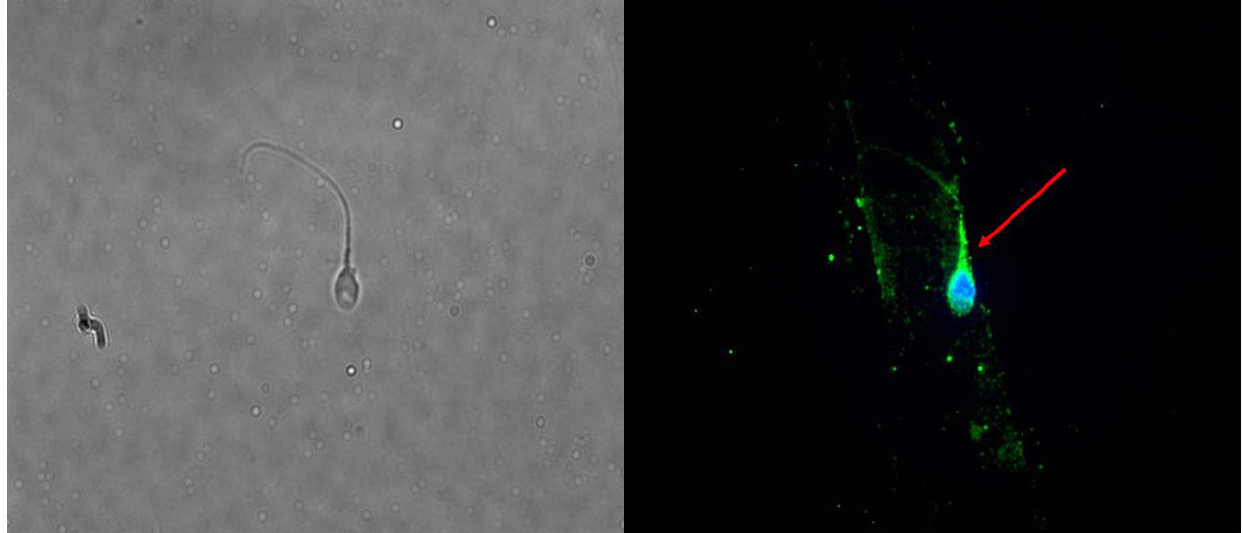
Figure 1. Immunolocalization of the follicle-stimulating hormone receptor (FSHR) protein in human spermatozoa. Immunofluorescence (IF) analysis of spermatozoa. The protein is present in the post- acrosomal segment, neck, midpiece, and tail of the spermatozoon. Magnification 100×. IF is indicated by the red arrow.